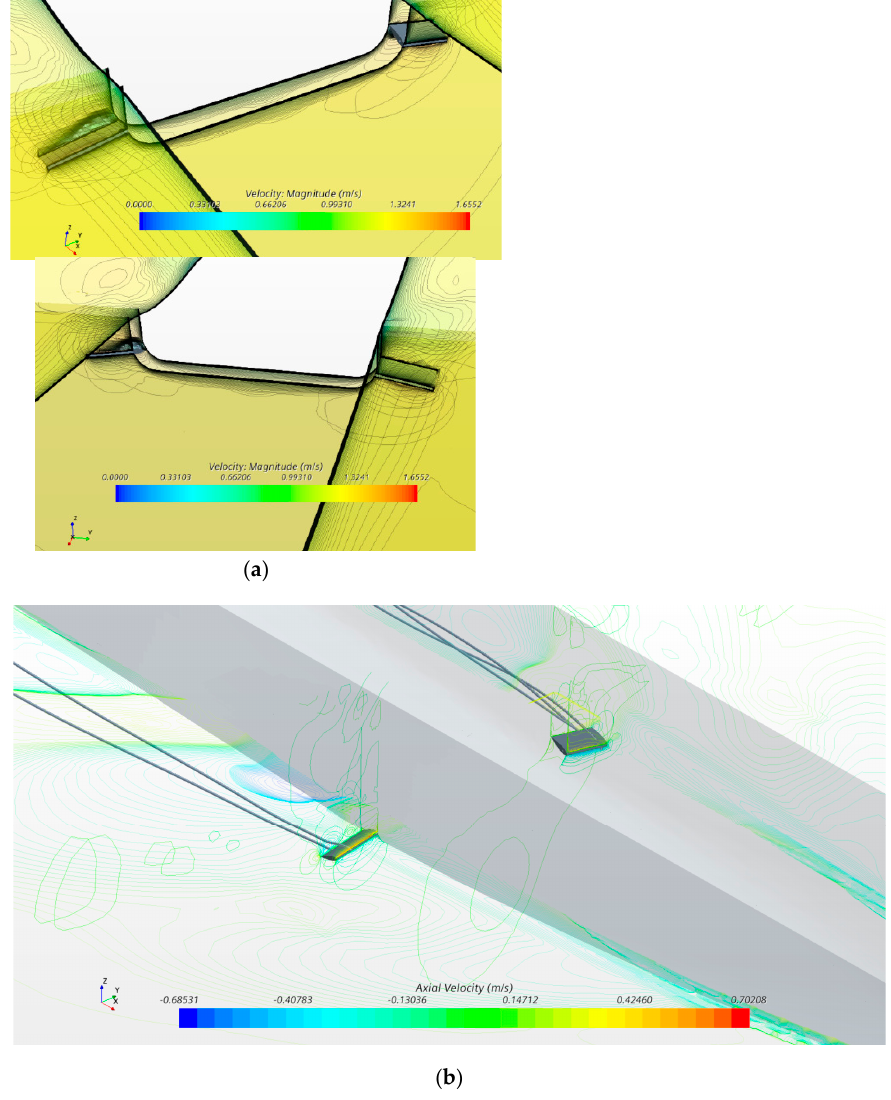
Figure 16. Flow analysis for asymmetry 20° fins. ( a ) Velocities at fin areas on both sides with free surface elevation. ( b ) Axial velocity distribution at sectional surface of fin with streamlines.